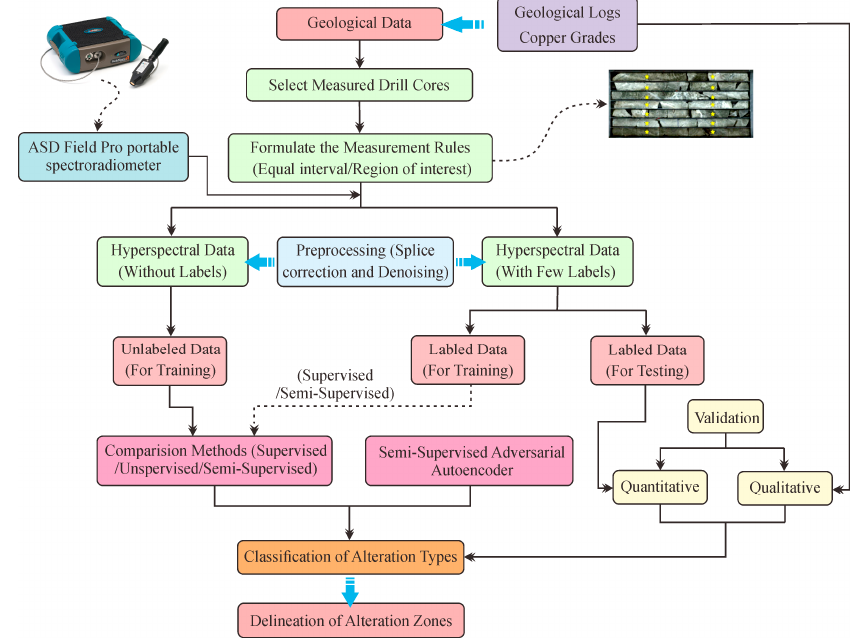
Figure 2. An overall flowchart used to delineate the alteration zones.